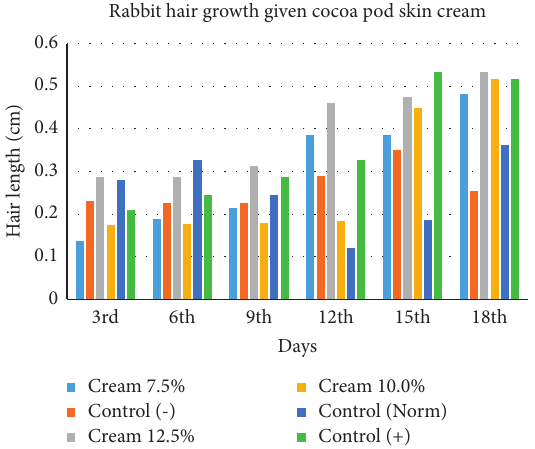
Figure 1: Rabbit hair length with cocoa pod skin